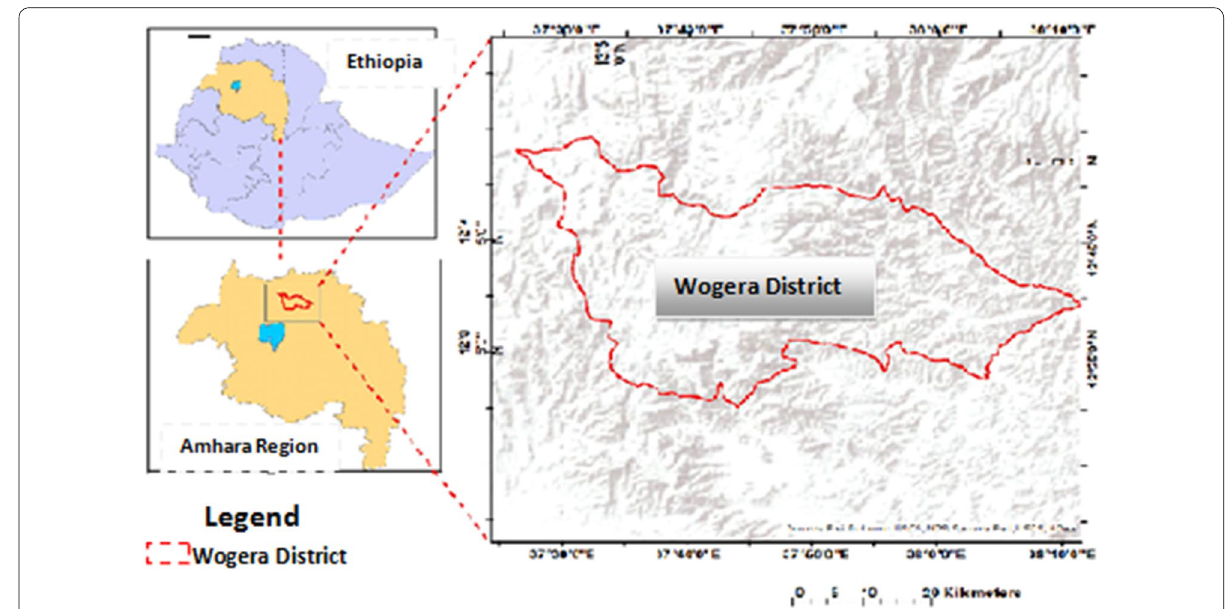
Fig. 1 Location map of the study